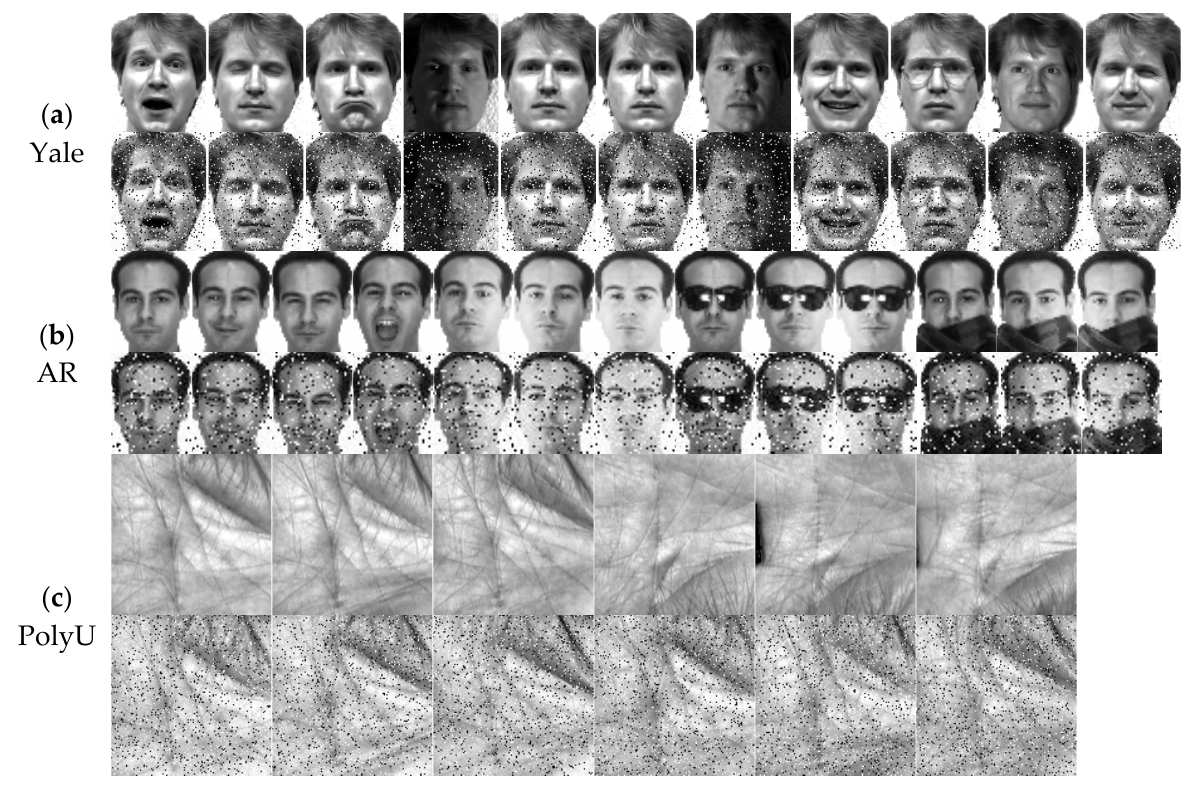
Figure 6. Some the original images and corrosion images on the three different databases. ( a ) Yale, ( b ) AR, and ( c ) PolyU.